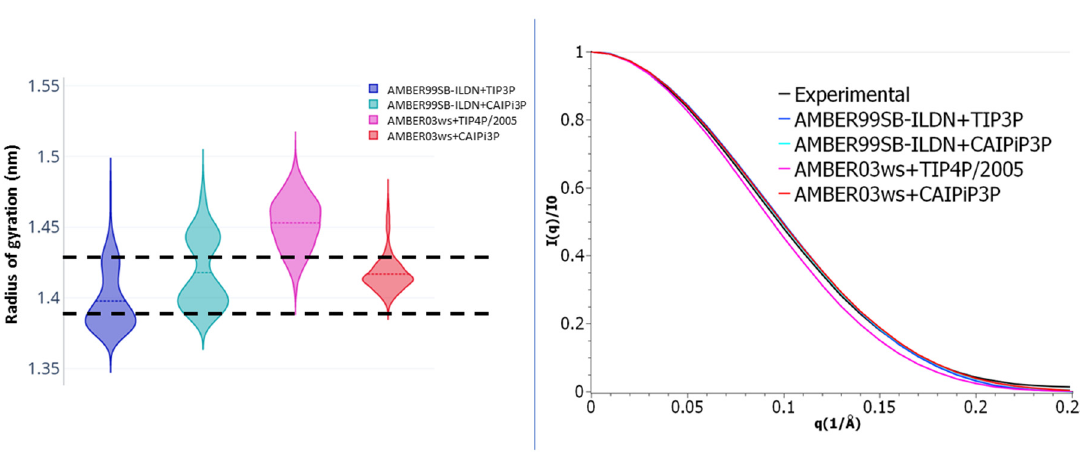
Figure 9. ( Left panel ) LaRP6-RRM1 radius of gyration violin plots; the experimental radius of gyration range is shown as dashed lines. ( Right panel ) Scattering profile for the LaRP6-RRM1 for simulations with different force field-water model combinations. Table 4. Reduced χ 2 and RMSD metric for I/I 0 distribution for LaRP6 LAM and LaRP6 RRM1.